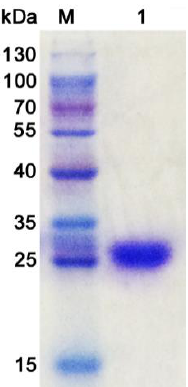
Figure 2. Sodium dodecyl sulfate-polyacrylamide gel electrophoresis (SDS-PAGE) analysis of purified CsnM. (M, molecular marker; 1, purified CsnM).